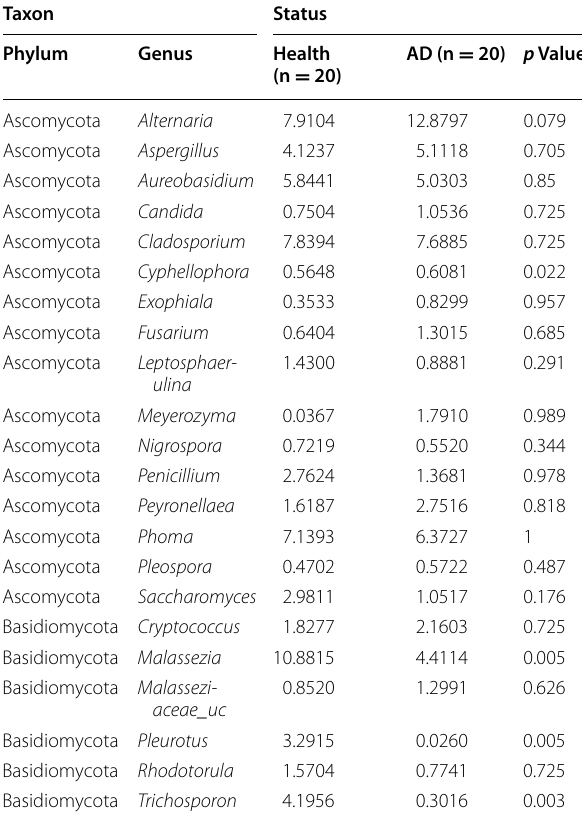
Table 2 List of fungal genera and their relative